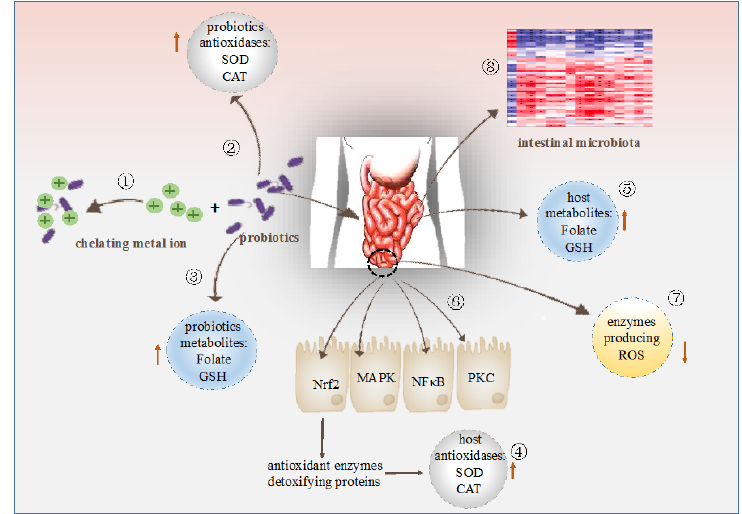
Figure 2. Modulation of antioxidation by probiotics. ① Probiotics chelate metal ion. ② Probiotics possess their own antioxidases. ③ Probiotics produce antioxidant metabolites. ④ Probiotics up-regulate antioxidase activities of the host. ⑤ Probiotics increase levels of antioxidant metabolites